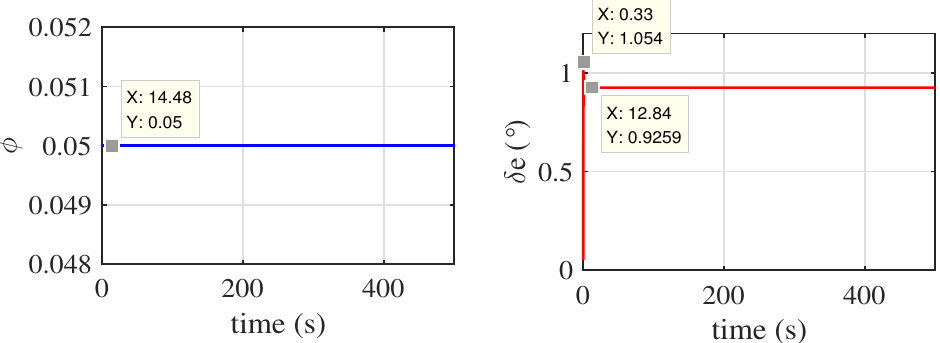
Figure 4. Control value proposed by PID controller in horizontal flight and fault free state. From 0 to 1, the loss fault rate increases by 0.05 each time. After a sequence of test, in the state of horizontal flight, the maximum fault rate the PID controller can tolerate is 0.35. Between 0.35–0.5, longitudinal velocity can be controlled but the altitude is unwarrantable. If the actuator loss exceeds 0.5, the whole system will be out of contol. Figures 5–7 are the comparison of PID controller and L 1 adaptive fault tolerance controller at fault rate 0.45. It is obvious that L 1 adaptive fault tolerance controller is more advanced than PID controller in horizontal flight. Both controllers have almost the same performance at longitudinal velocity control. But both curves of altitude and track angle oscillate obviously with PID controller. By contrast, the L 1 adaptive fault tolerance controller makes both the altitude error and track angle almost stable at